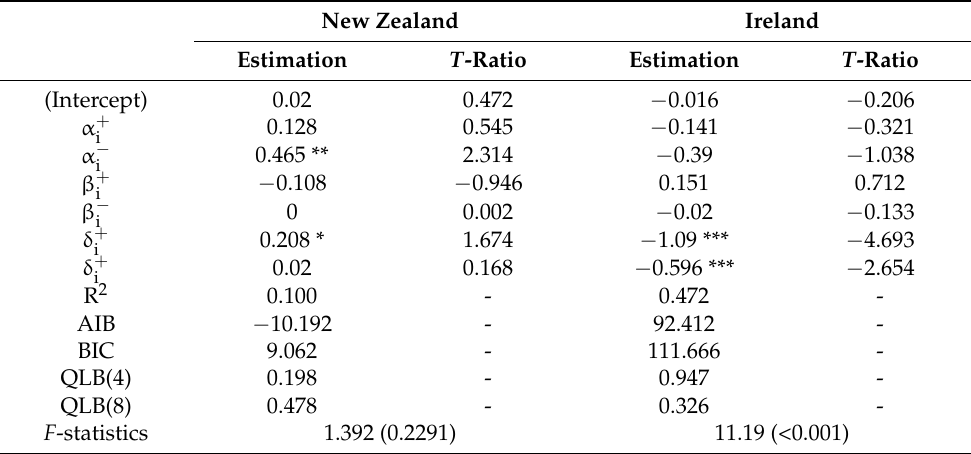
Table 8. Results of the asymmetric error correction model with consistent MTAR. New Zealand Ireland Estimation T -Ratio Estimation T